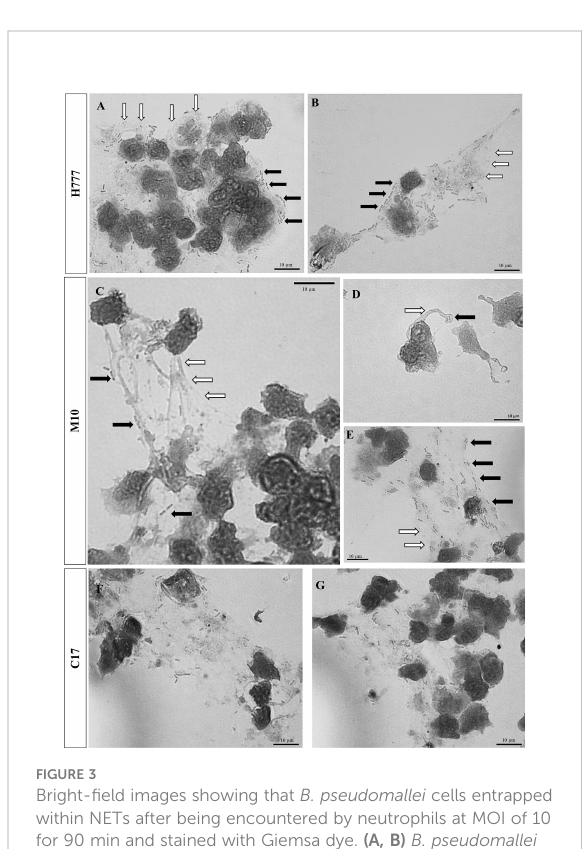
FIGURE 3 Bright- fi eld images showing that B. pseudomallei cells entrapped within NETs after being encountered by neutrophils at MOI of 10 for 90 min and stained with Giemsa dye. (A, B) B. pseudomallei H777 (rod shape, black arrow) trapped by aggregated NET (gray area, white arrow); (C) B. pseudomallei M10 entrapped within NETs, (D) B. pseudomallei M10 entrapped in spiky NETs; (E) B. pseudomallei M10 trapped within aggregated NETs. (F, G) B. pseudomallei C17 entrapped within aggregated NETs. Scale bars = 10